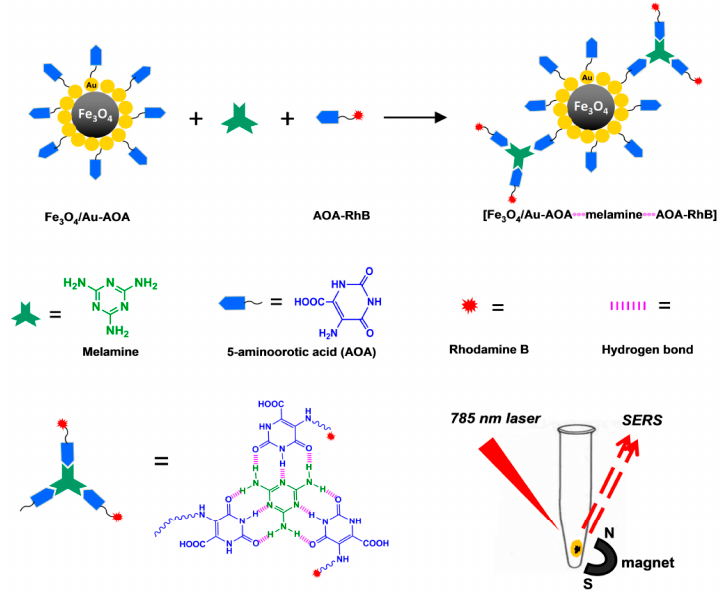
Figure 12. The H-bonding assisted [Fe 3 O 4 /Au–AOA ••• melamine ••• AOA–RhB] surface-enhanced Raman spectroscopy (SERS) matrix (reproduced with permission from Reference